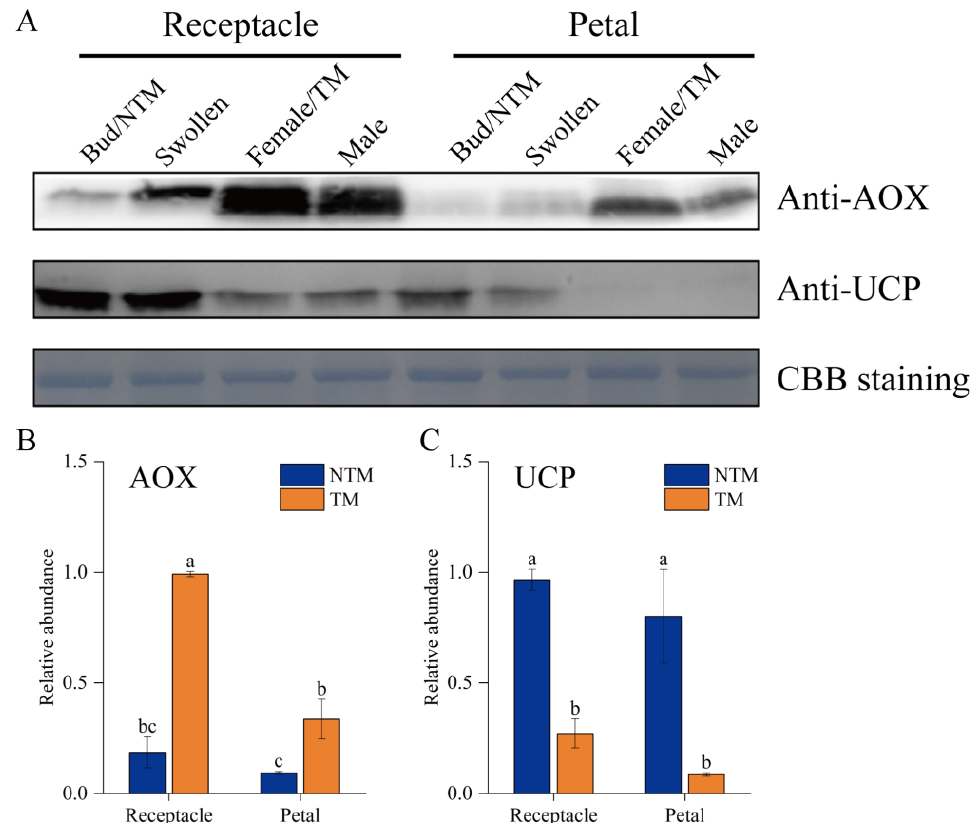
Figure 6. Western blot analyses of AOX and UCPs in receptacle cells during the NTM and TM stages. ( A ) Both AOX and UCPs were detected in the receptacles and petals during floral thermogenesis. Coomassie brilliant blue (CBB) staining is shown as a protein loading control. ( B ) Statistical analysis of protein abundance was based on three biological replicates for AOX and three for UCPs. Data in the bars are the mean ± standard error. AOX abundance was significantly higher during the TM than NTM stage in both the receptacles and petals. ( C ) UCP abundance were significantly higher during the NTM than TM stage in both the receptacles and petals. The different lowercase letters indicate a significant difference in protein abundance according to the t -test. n = 3 samples with three biological repeats. p < 0.001 versus TM receptacle group.